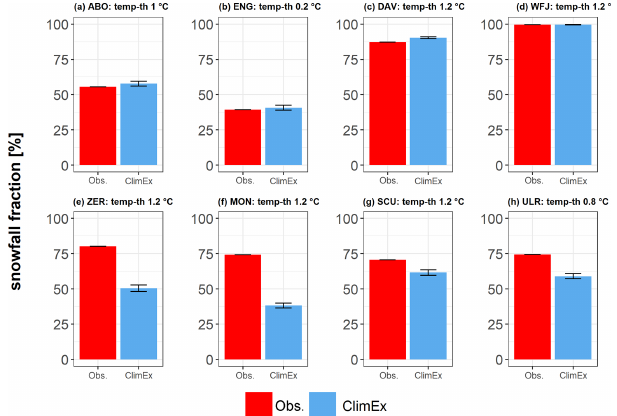
Figure 3. Mean winter snowfall fraction based on observations (obs; red) and for the bias-adjusted ClimEx LE (blue) for the pe- riod 1984 to 2009. temp-th indicates the calibrated snowfall–rainfall separation threshold for the respective station. See Table 1 for the abbreviations of case studies.